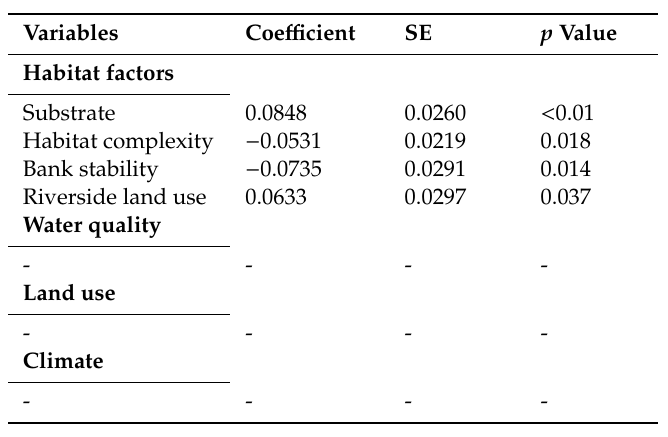
Table5. AssociationsBetweenEnvironmentalVariablesandthemeantrophiclevel(MTL)ofNon-Native Fish